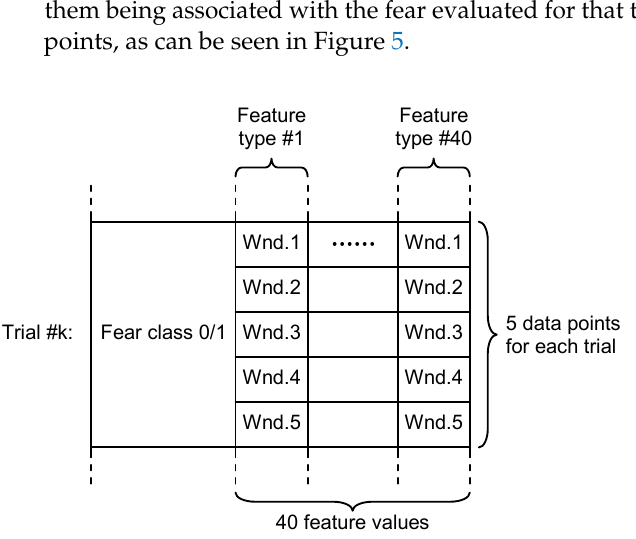
Figure 5. Dataset structure for overlapping approach.